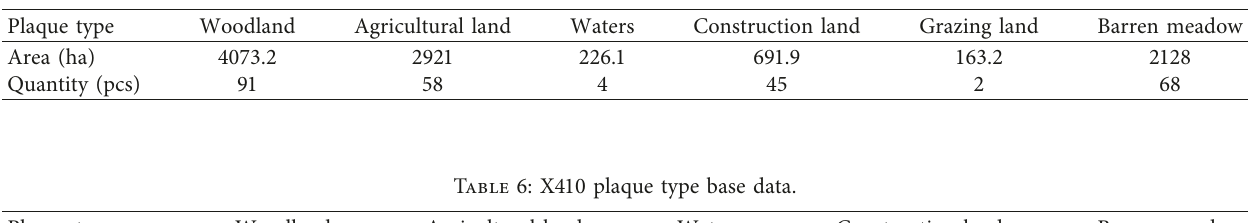
Table 5: Basic data of plaque types in the Chongli-Akagi section of G335.